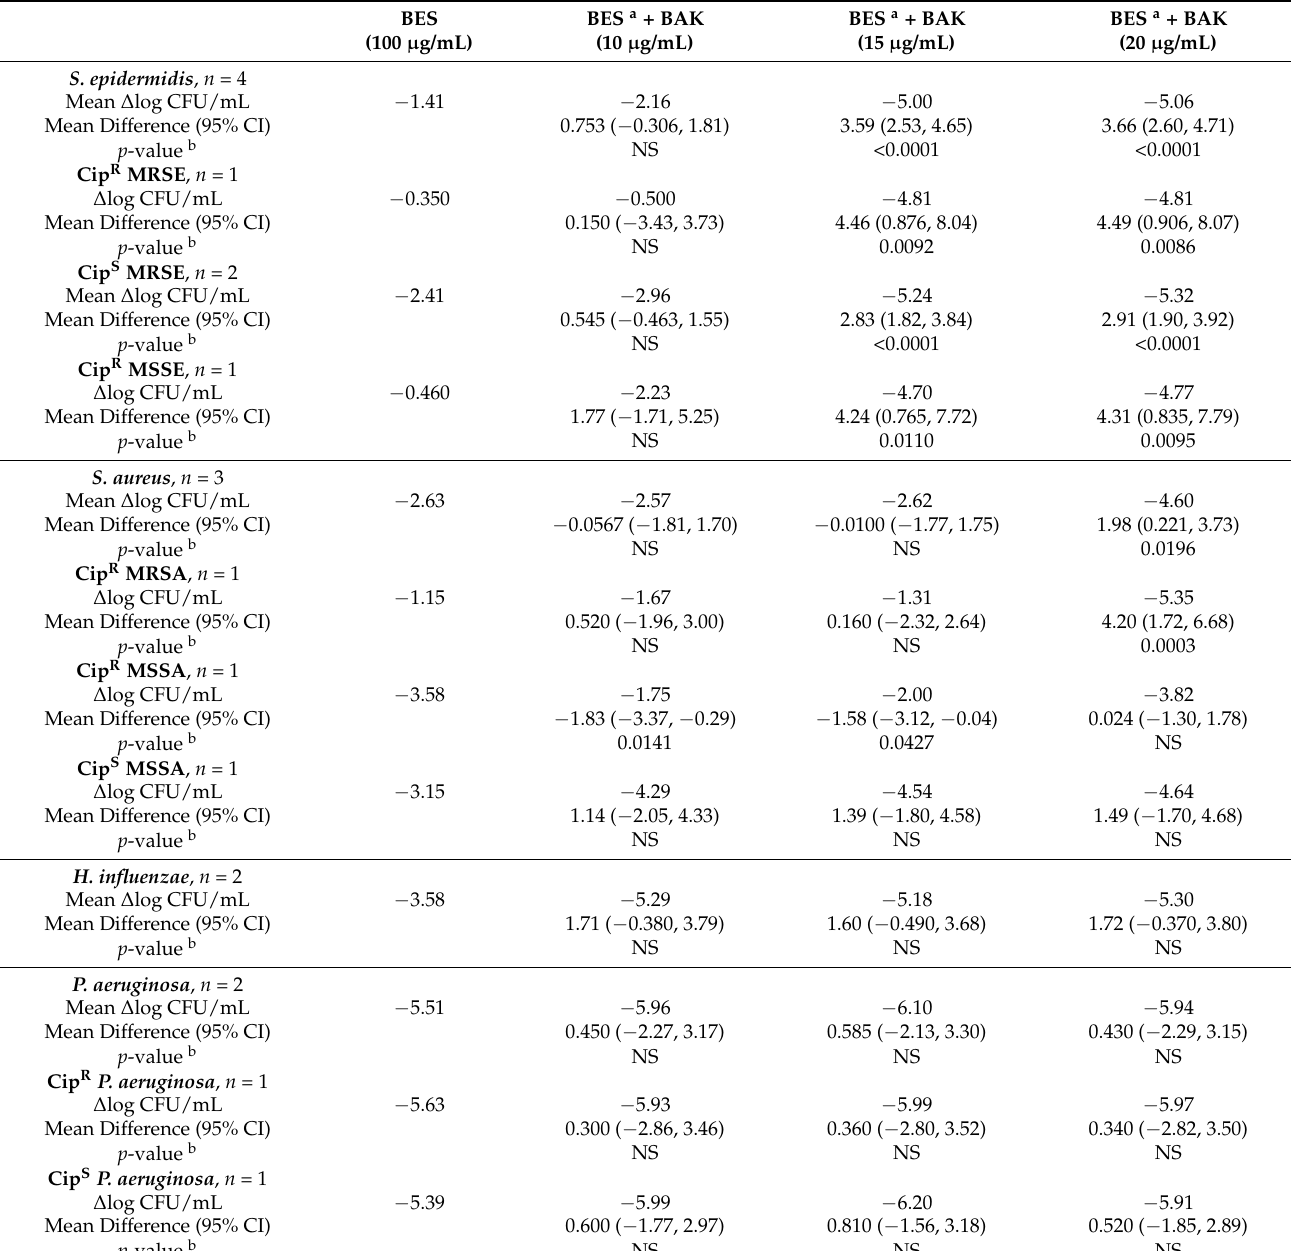
Table 1. Bacterial kill after 180 min for besifloxacin alone and besifloxacin in combination with BAK.